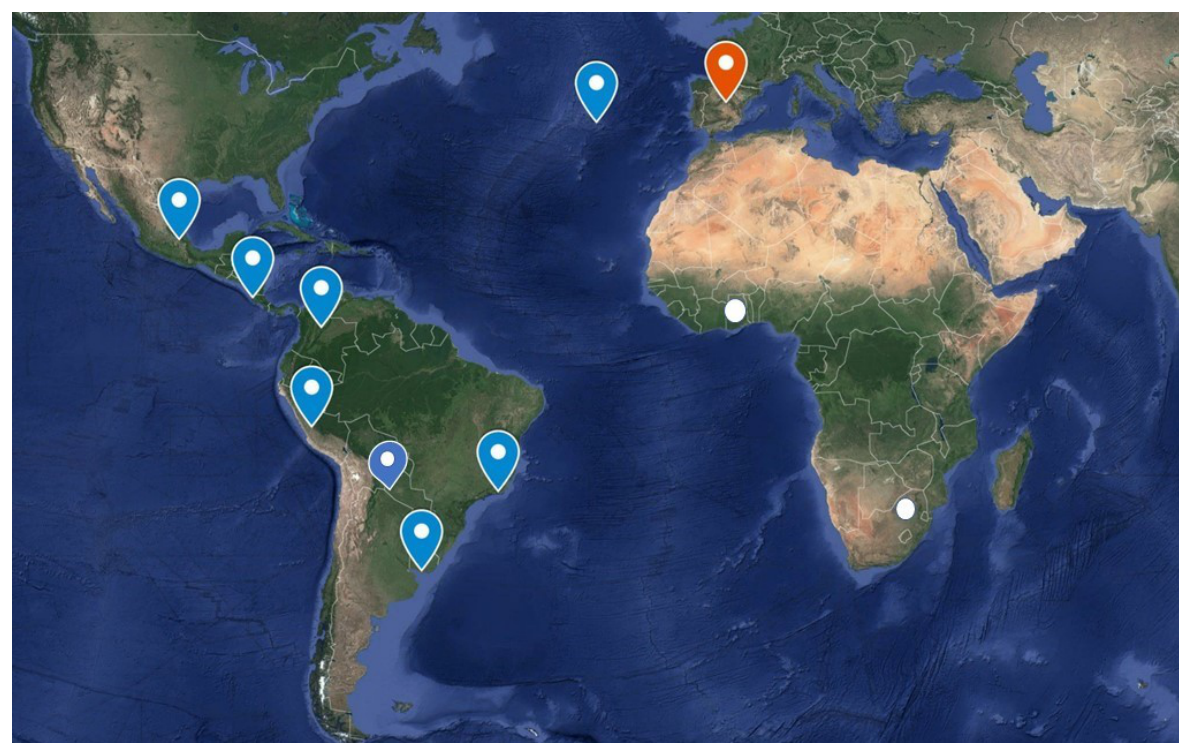
Figure 2. The position of the main antennas participating in IVIA. In South America, the antena of Paraguay has been added to the original map of IVIA. In Brazil, only the Tanguá antenna is shown, although another antena at Morungaba, São Paulo State, might participate in future. The antena in the ocean is the one of Azores, belonging to Portugal. The Yebes Antenna in Spain is shown in red; it is currently participating in VLBI observations with the European network. Two antennas are shown in Africa, in Ghana (Kuntunse Satellite Earth Station) and South Africa (Hartebeesthoek, near